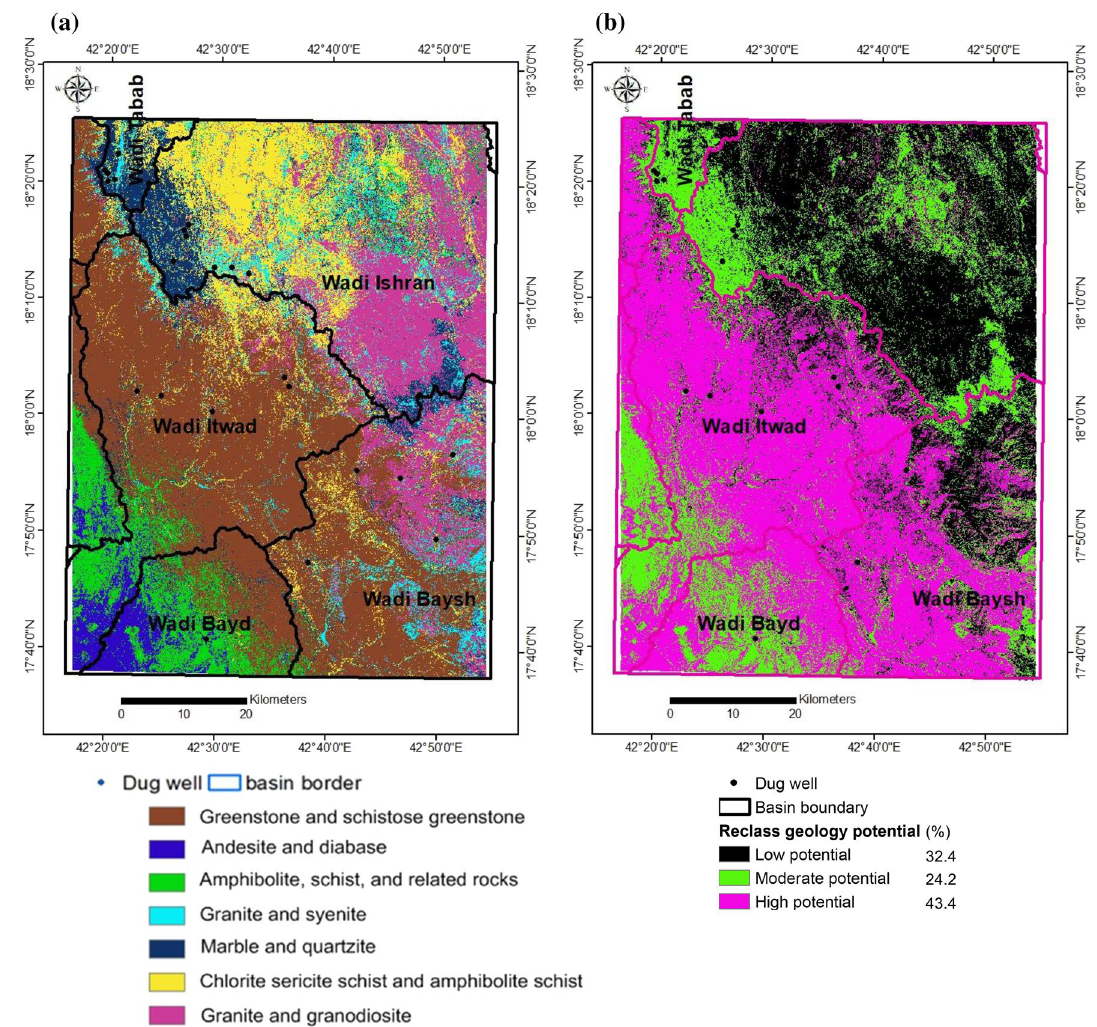
Fig. 8 a Geology and b reclassified geology of the study